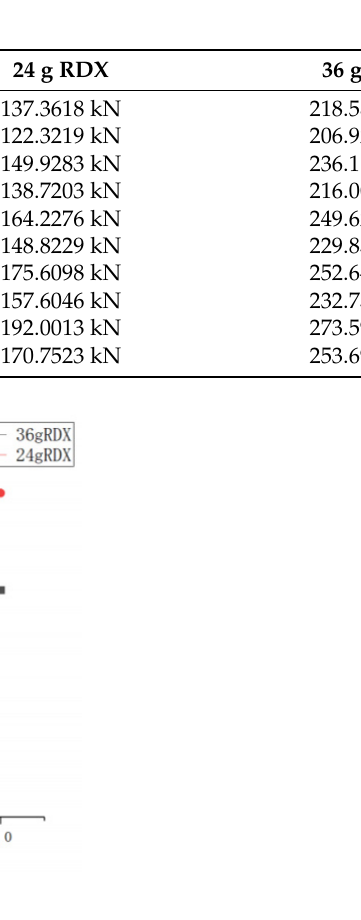
Figure 9. 1/4 LS-DYNA calculation model.